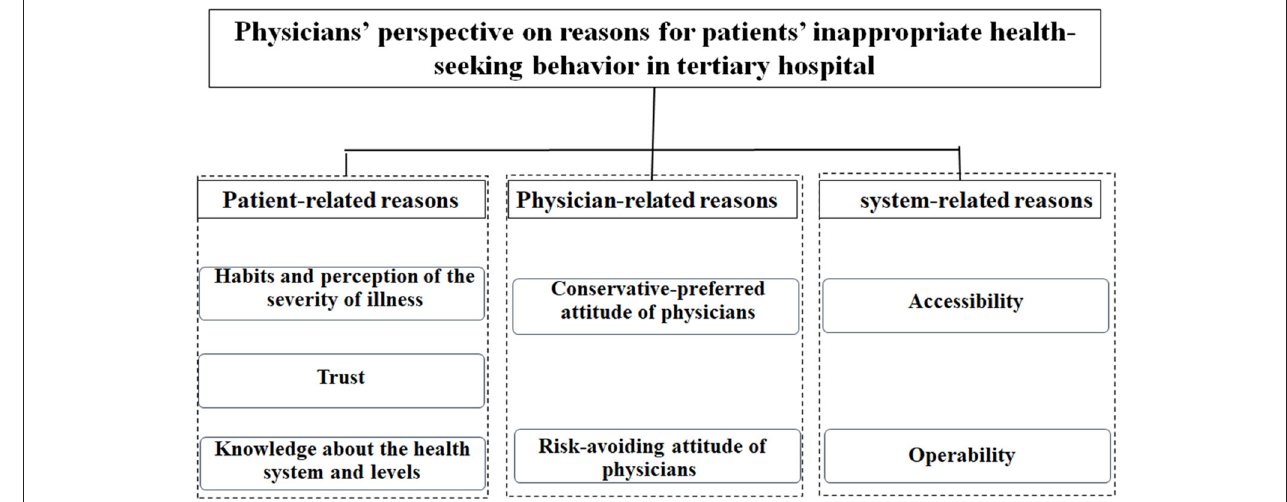
FIGURE 2 | Results identified by the qualitative